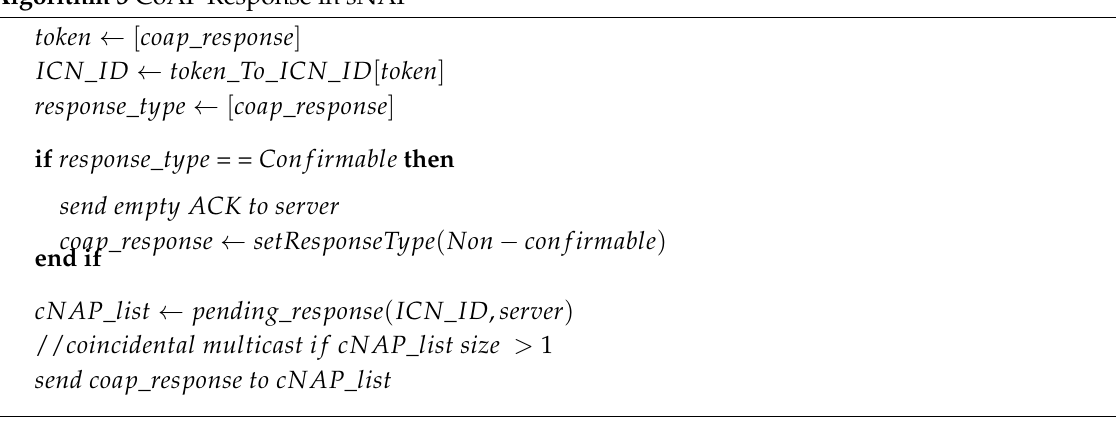
Algorithm 3 CoAP Response in sNAP